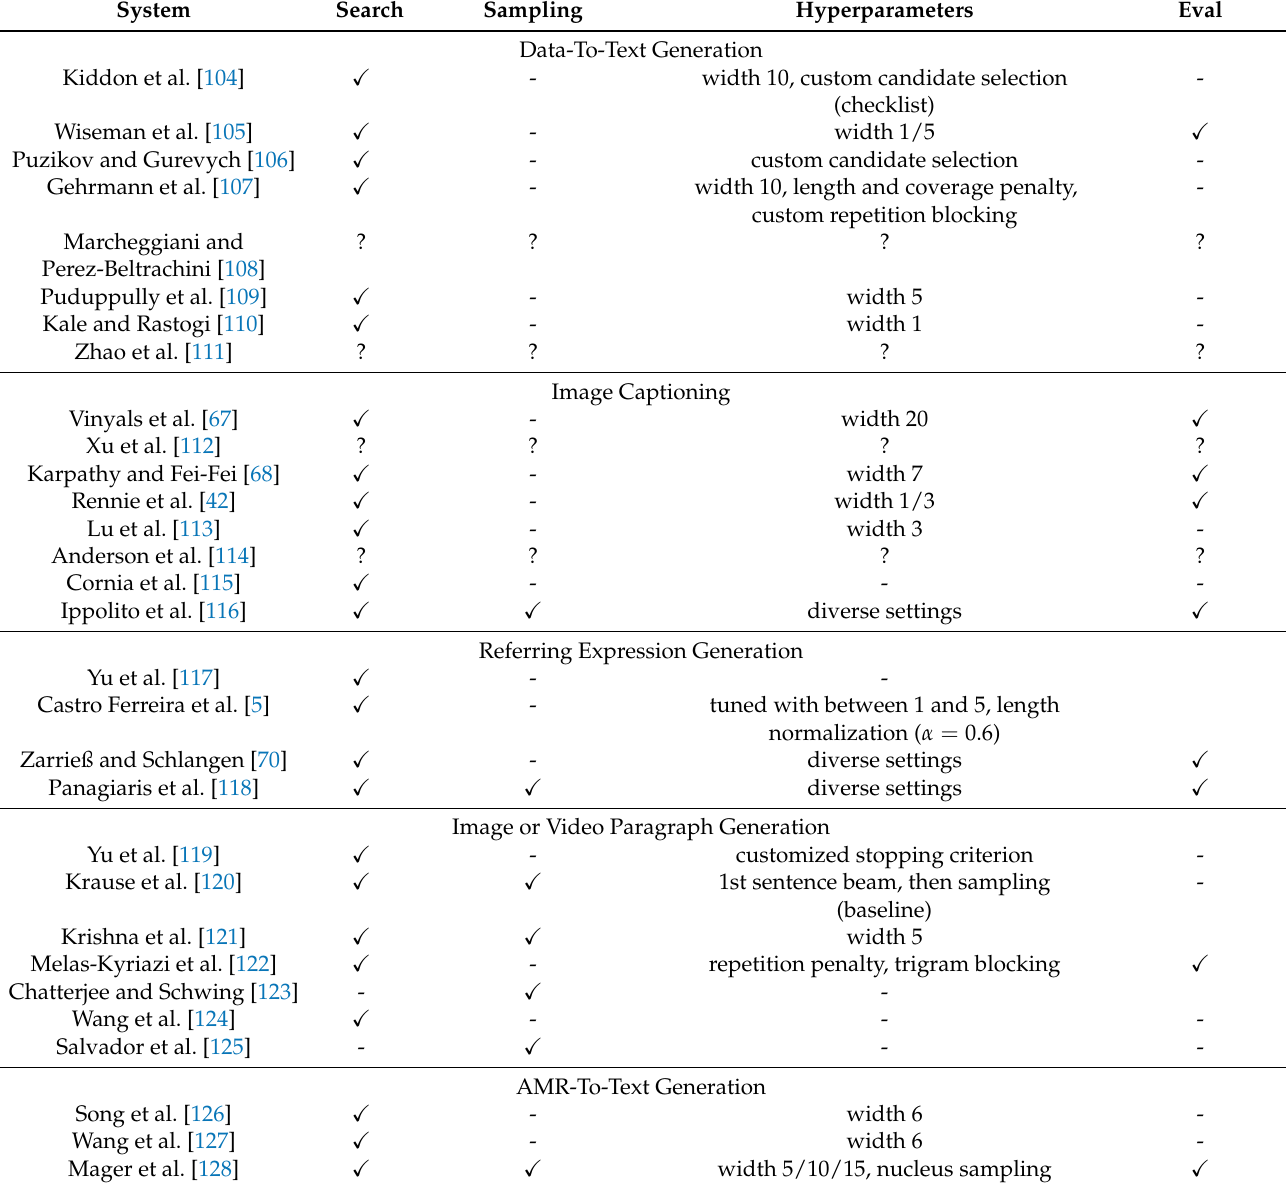
Table 3. Neural data-to-text or image-to-text systems and their decoding